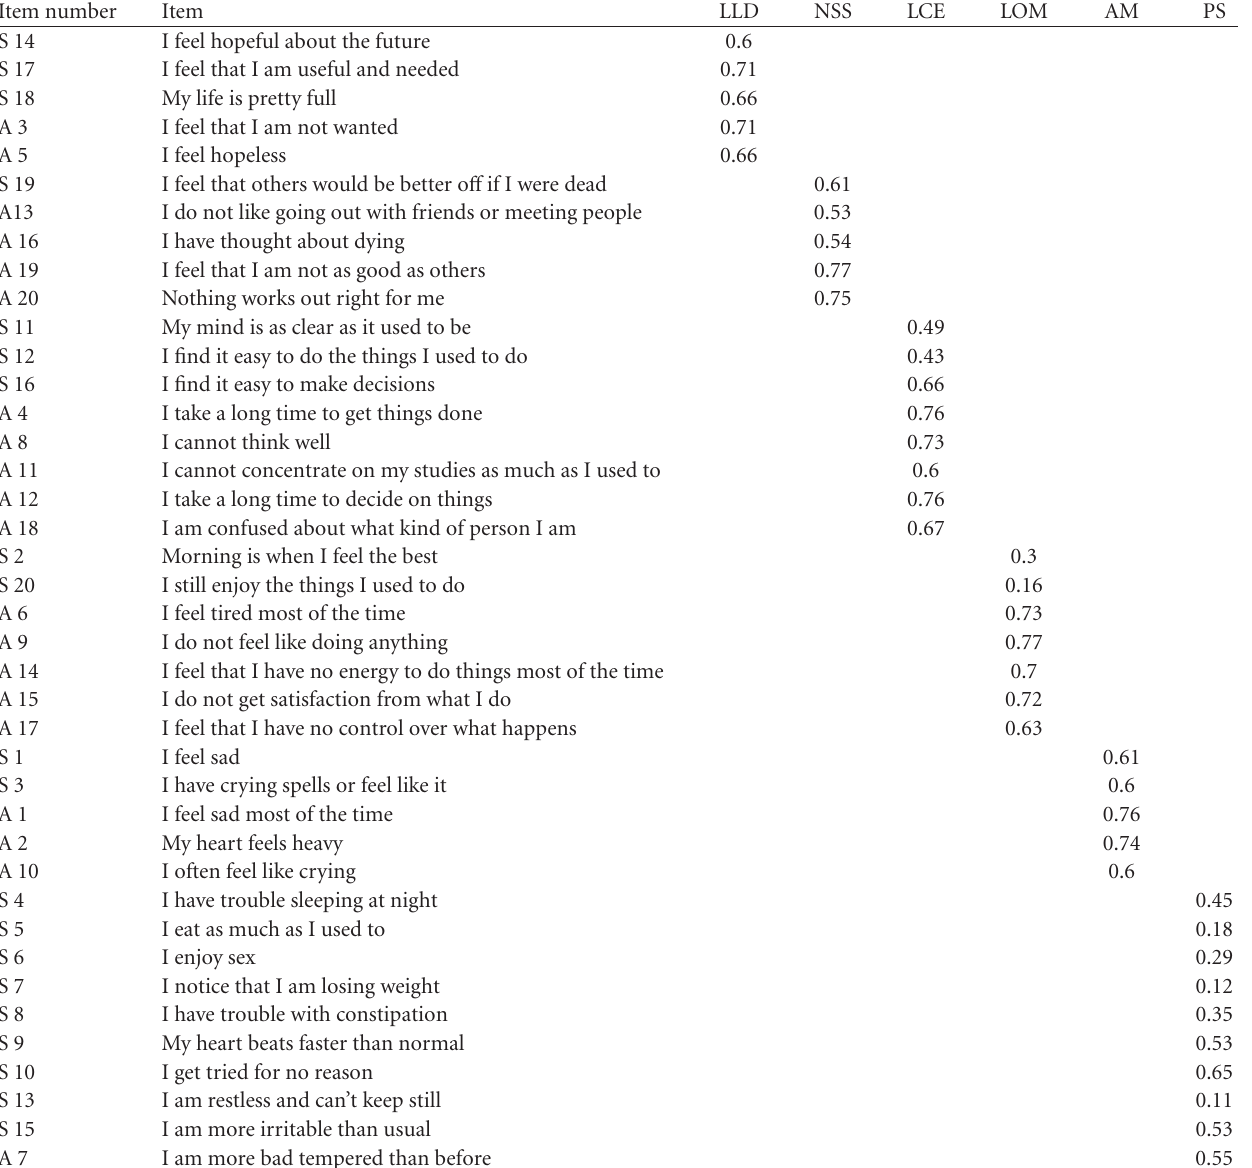
Table 2: Factor structure and factor loading of Self-Rating Depression Scale and Asian Adolescent Depression